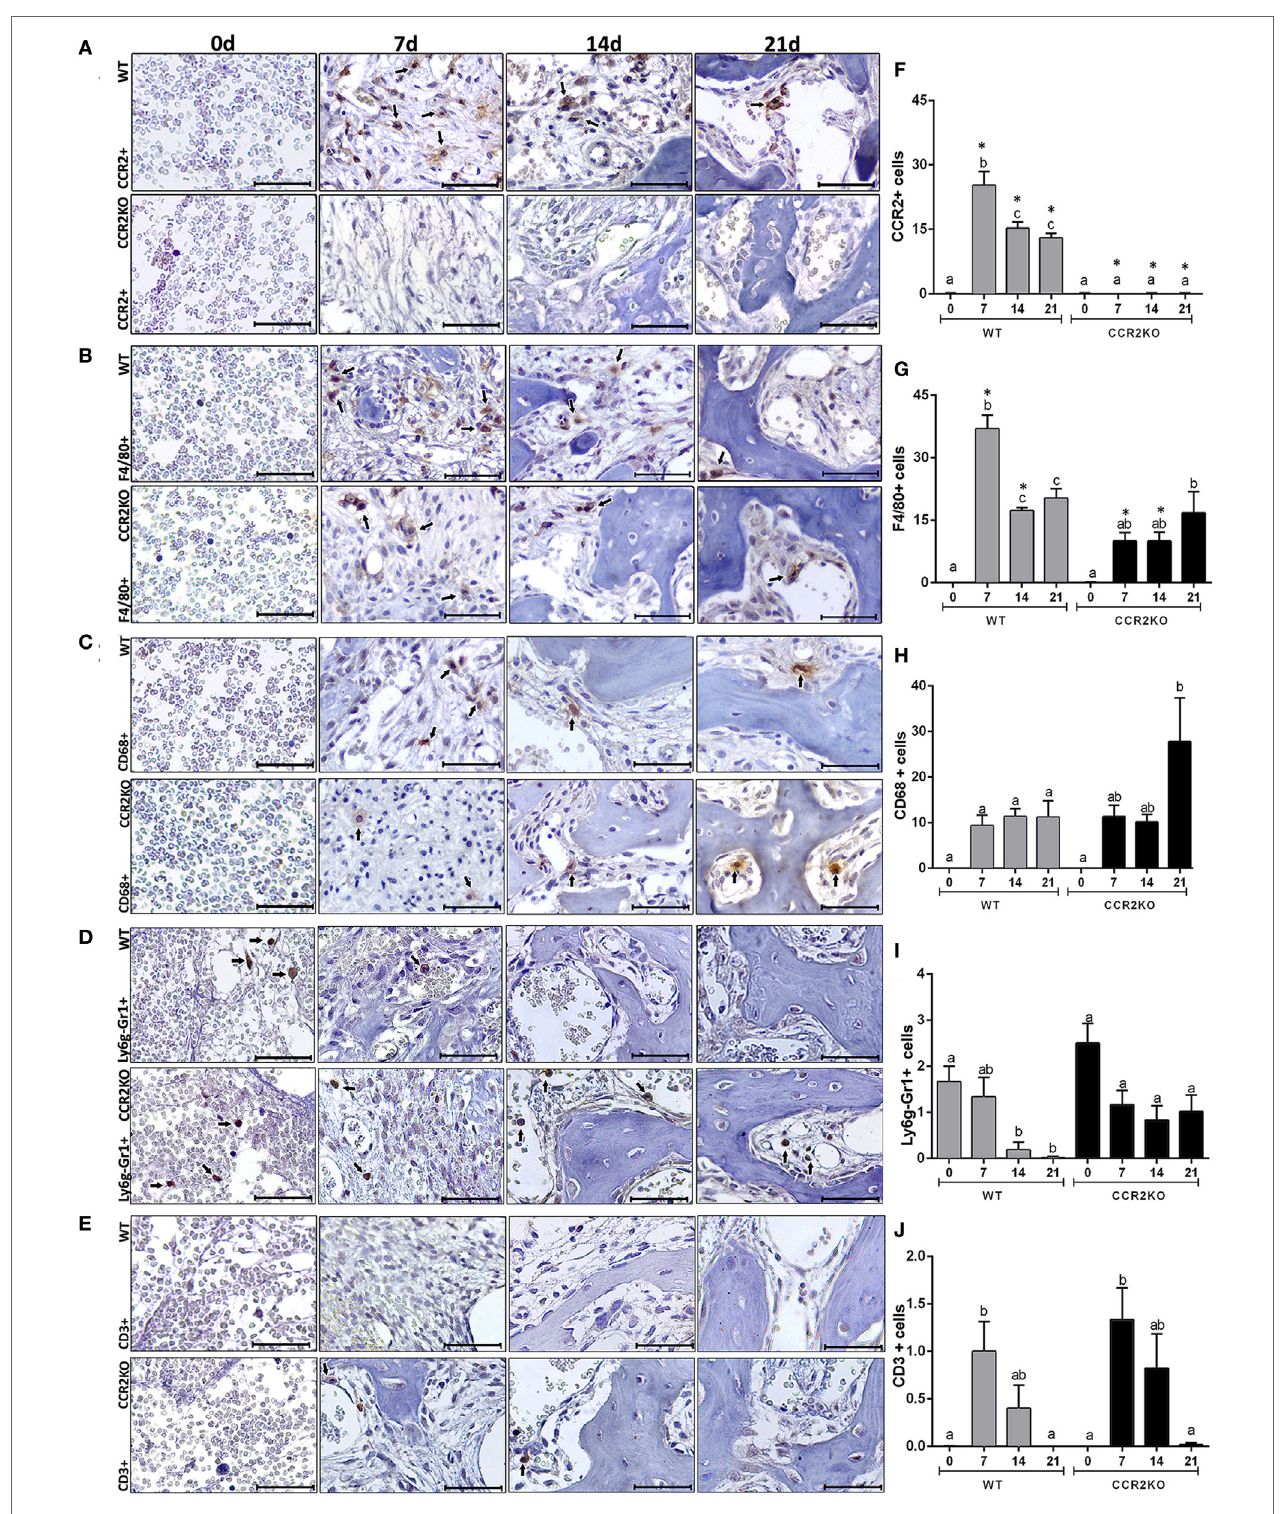
FigUre 1 | Immunolabeling of inflammatory infiltrate in the intramembranous alveolar bone healing in mice. Representative sections from medial thirds of the socket at 0, 7, 14, and 21 days post tooth extraction with immunolabeling of CCR2 + cells (a) , F4/80 + cells (B) , CD68 + cells (c) , Ly6g-Gr1 + cells (D) , and CD3 + cells (e) in wild-type (WT) (a) and CCR2KO mice (B) , as indicated with arrows (scale bar = 100 µm). Quantitative and comparative analysis of CCR2 + cells (F) , F4/80 + cells (g) , CD68 + cells (h) , Ly6g-Gr1 + cells (i) , and CD3 + cells (J) in WT vs CCR2KO mice at days 0, 7, 14, and 21 post-extraction. Different letters indicate significant differences in each time point ( p < 0.05); symbol * indicate significant differences between WT vs CCR2KO at the same time